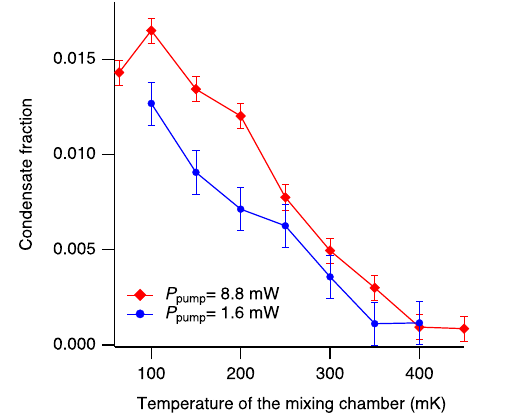
Fig. 5 | Condensate fraction as a function of the temperature of the mixing chamber. Blue and red circles represent the condensate fraction for 1.6 and 8.8mW excitation powers,respectively. Red and Blue bars represent experimental uncertainty for each point determined by the dynamic range of the absorption